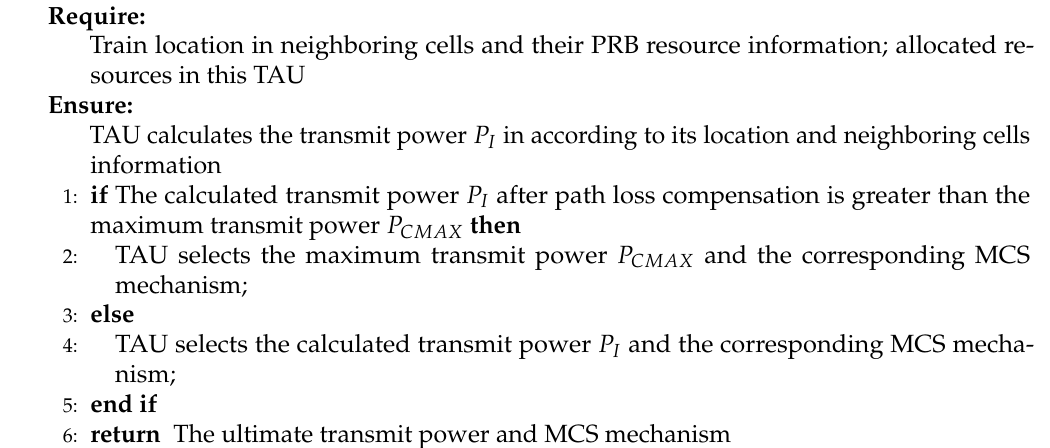
Algorithm 1 Location based uplink power control